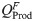
Changes in production question QProdF resulting from a local update of the auditory-motor internal model P(AM | M).The update magnitude is equal to the perturbation magnitude (horizontal arrow). The vertical dashed line indicates the shift in control space that would result in complete compensation.